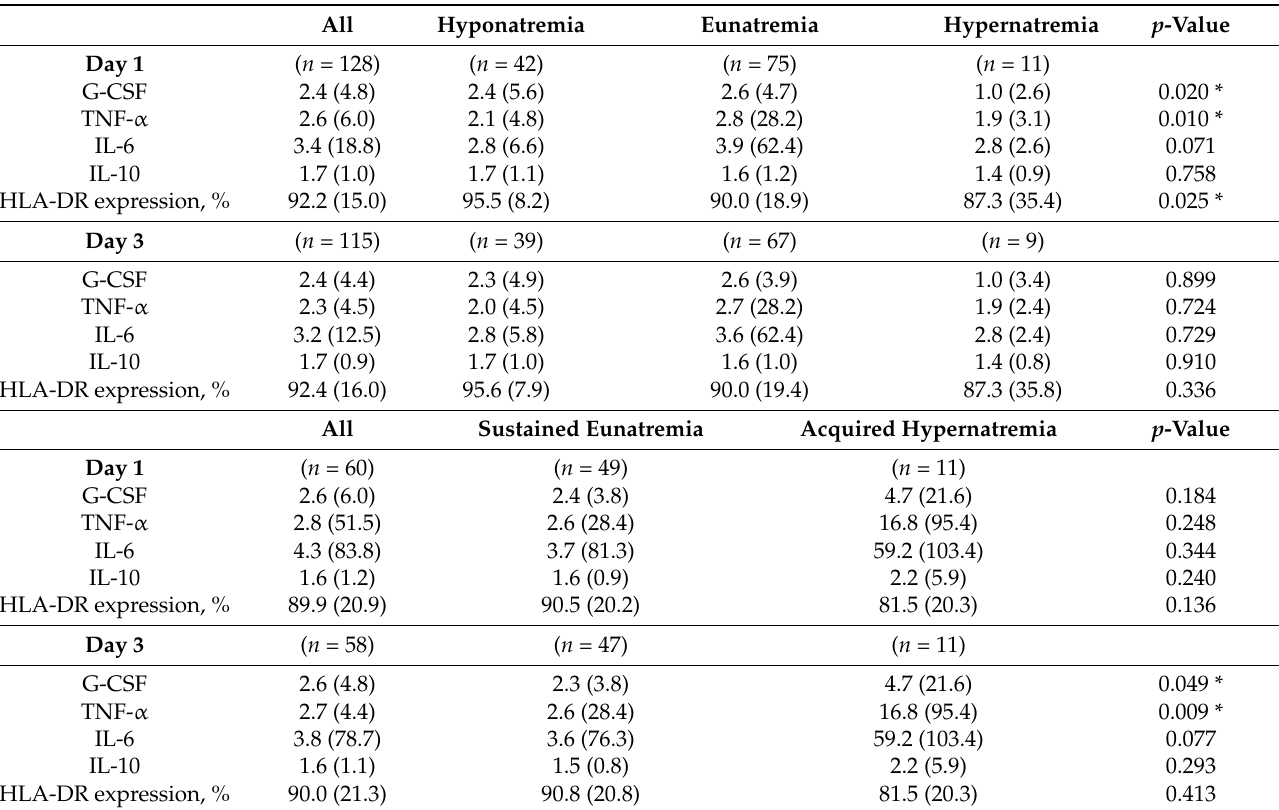
Table 4. Immune stimulation response and HLA-DR-expressing monocyte percentage in patients with